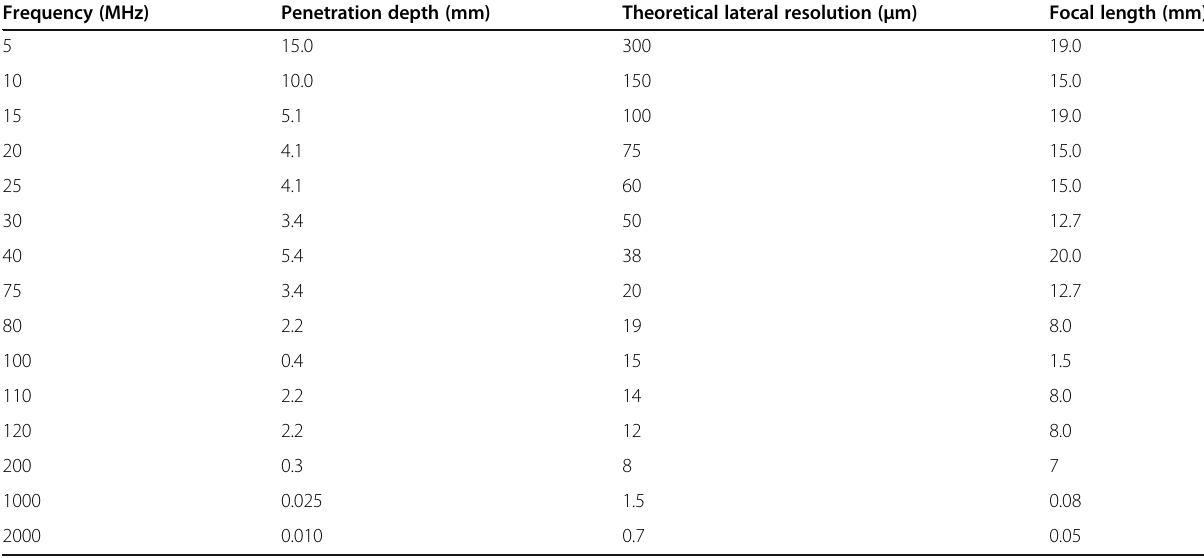
Table 2 Resolution and penetration depth of an acoustic microscope a Frequency (MHz)